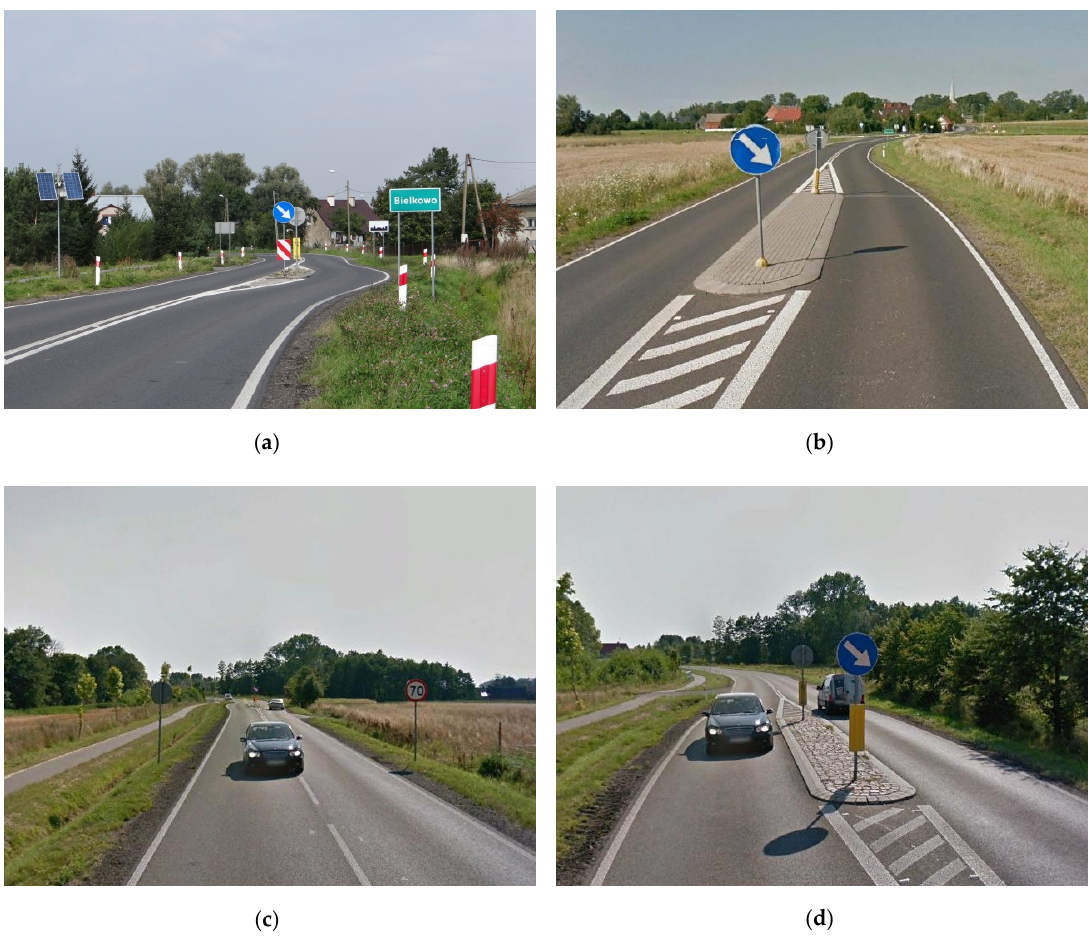
Figure 17. View of the village skyline of village as seen by a driver approaching the chicane: ( a ) View of nearby buildings at chicane No. 1, sign E-17 located 5 m before the chicane and sign D-42 located 30 m after the chicane; ( b ) Distant view of the village skyline near the chicane No. 2, sign E-17 located 100 m after the chicane and sign D-42 located 150 m after the chicane; ( c ) Lack of the village skyline view on the approach to the chicane No. 3, being a central island deflecting both lanes; ( d ) Lack of the view of village buildings from the chicane No. 3 location, sign E-17 located 150 m after the chicane and sign D-42 located 300 m after the chicane.